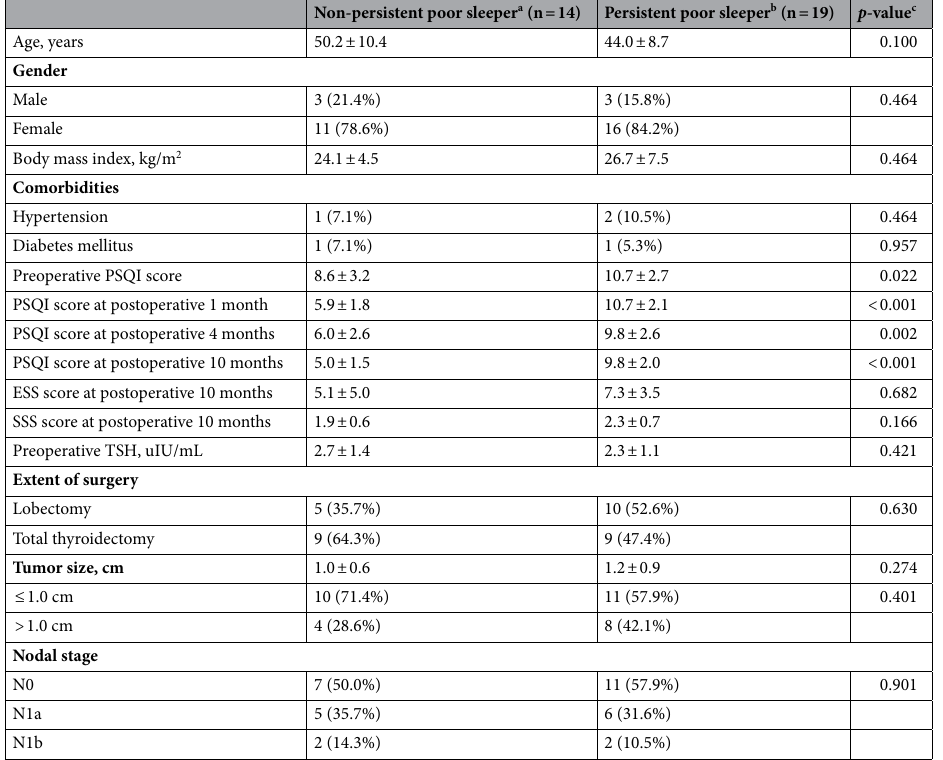
Table 4. Comparison of clinicopathological characteristics between non-persistent and persistent poor sleepers. PSQI Pittsburgh sleep quality index, ESS Epworth sleepiness scale, SSS Stanford sleepiness scale, TSH thyroid stimulating hormone. a Non-persistent poor sleeper was defined as a patient who had a PSQI score of 7 or less at postoperative 10 months. b Persistent poor sleeper was defined as a patient who had a PSQI score greater than 7 at postoperative 10 months. c p -values from the Mann–Whitney U test between non-persistent and persistent poor